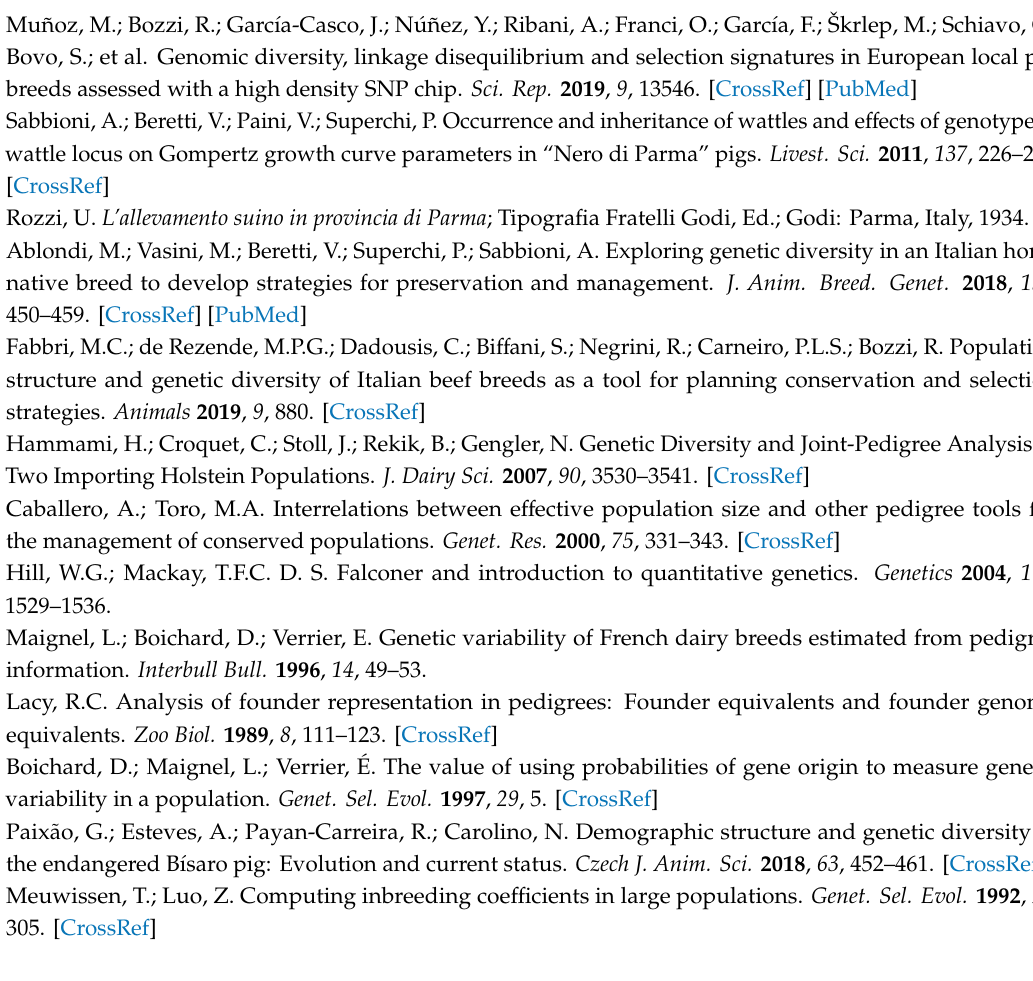
Figure S1: Trend of the mean equivalent complete generations (CGE) throughout the studied period within sex (female and